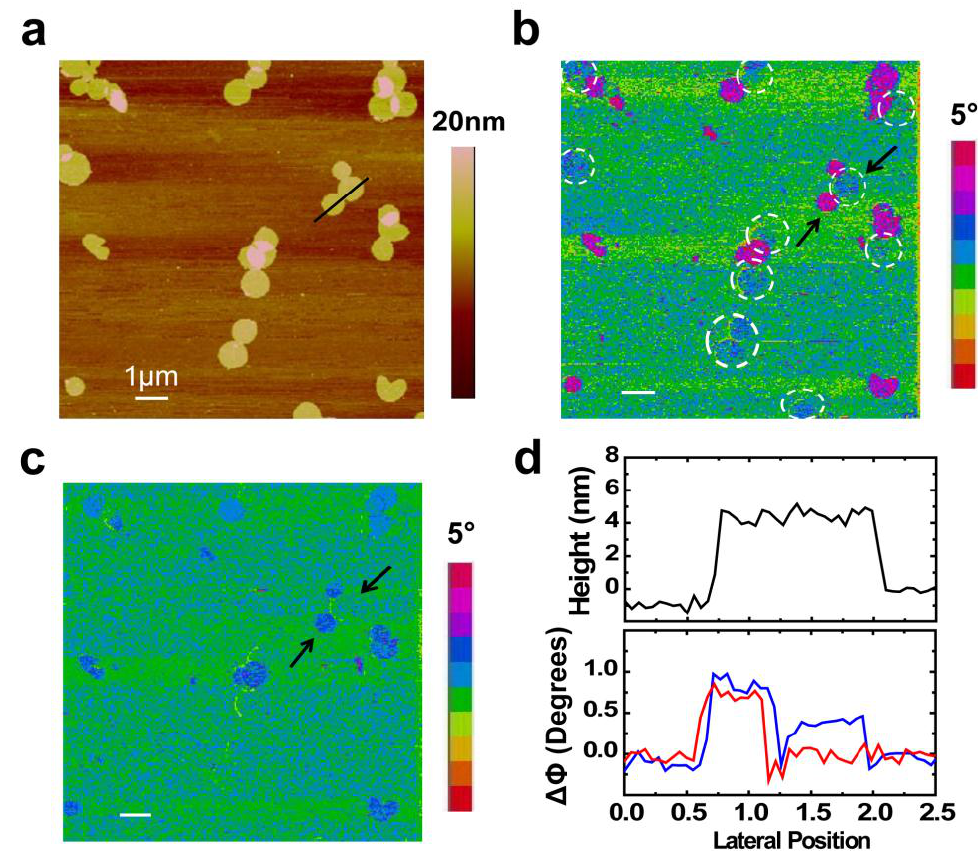
Figure 2. Atomic force microscopy (AFM) and electric force microscopy (EFM) images of PM. ( a ) Topography image of PM patches on silicon; ( b , c ) EFM phase images of the sample, with the V tip = − 1 V and 1 V, respectively; ( d ) Line scans of topography and phase centered along the lines in AFM and EFM images. Black curve corresponds to ( a ); blue curve corresponds to ( b ); and red curve corresponds to ( c ). Scale bar in each image is 1 μm.